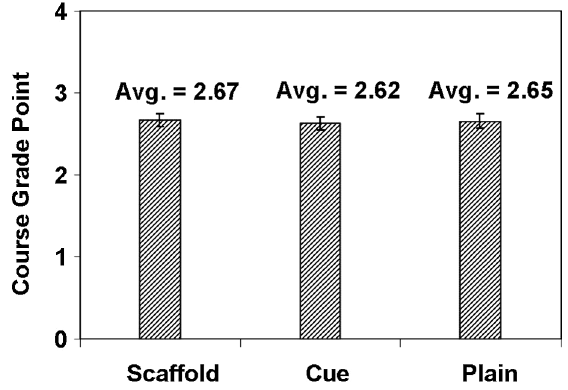
FIG. 4. Student grade points for a calculus-based introductory mechanics